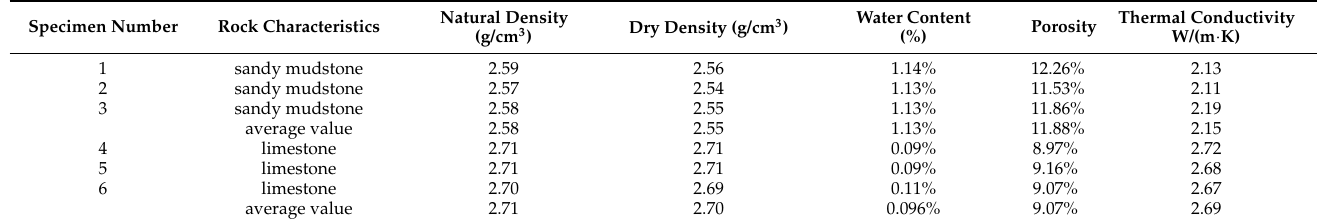
Table 1. Thermal physics parameters of the surrounding